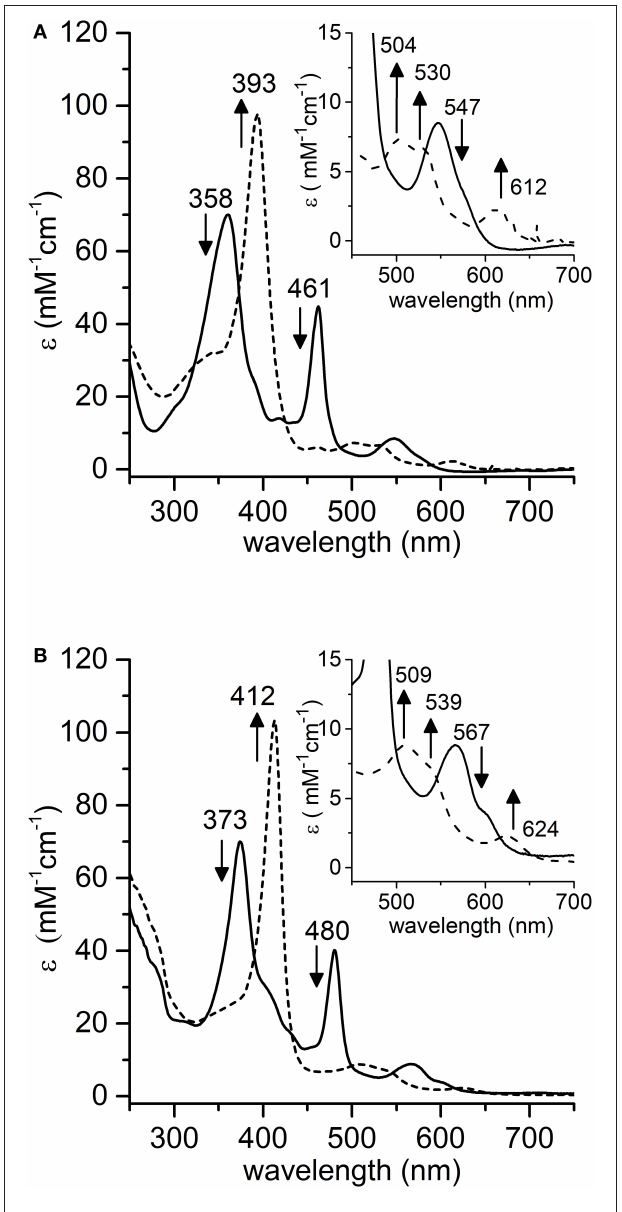
FIGURE 5 | Comparative UV-vis spectra of: (A) Mn-MC6*a (20 µ M, 60mM carbonate buffer pH 9.5 with 40% v/v TFE, T = 25 ◦ C) and (B) Mn-HRP (8.0 µ M, 100mM phosphate buffer pH 7.0, T = 25 ◦ C) before (plain lines) and after (dashed lines) addition of 100 eq. H 2 O 2 . Arrows indicate the direction of absorbance variations.